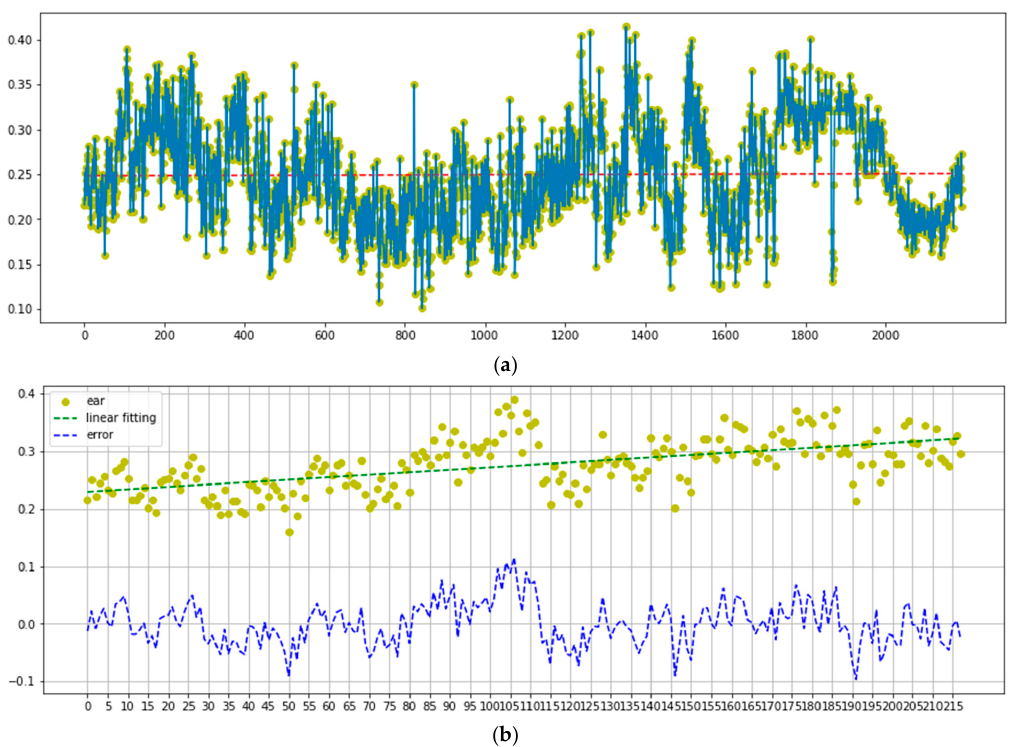
Figure 10. EAR and error analysis (Video 3, EAR threshold = 0.18). (a) Average EAR. (b) Error and EAR.